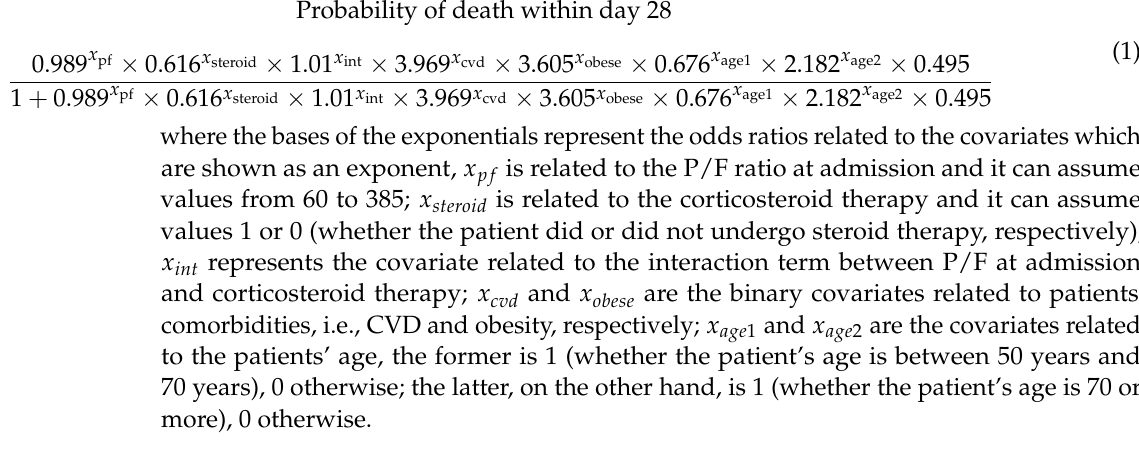
Table 3. Estimated margins of probability of death within 28 days with respect to P/F for exposed and unexposed cohorts. Difference column explains the steroid